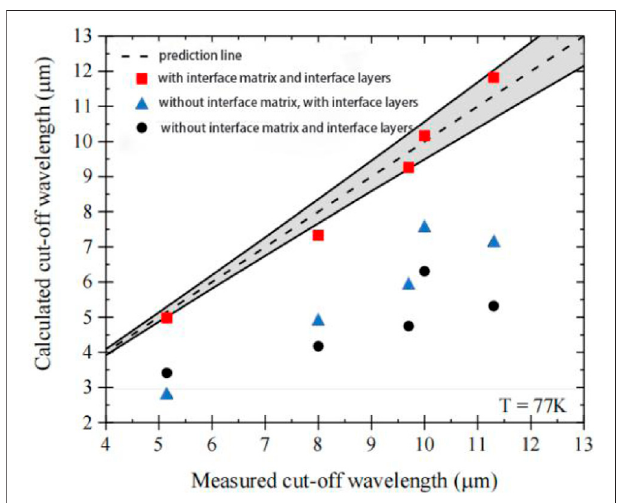
FIGURE 2 | Comparison between the calculated and measured cut-off wavelengths at 77 ° K for the different SL periods (red squares) along with the ideal prediction line (dashed line). Cut-off wavelengths calculated without the interface matrix (triangles) and considering neither the interface matrix nor the InSb layers (circles) are also plotted for comparison. The deviation in the predicted is represented by the solid lines and the grey area. The 10 ML (InAs)/4 ML (GaSb) SL was under compressive strain on GaSb with a large lattice mismatch and